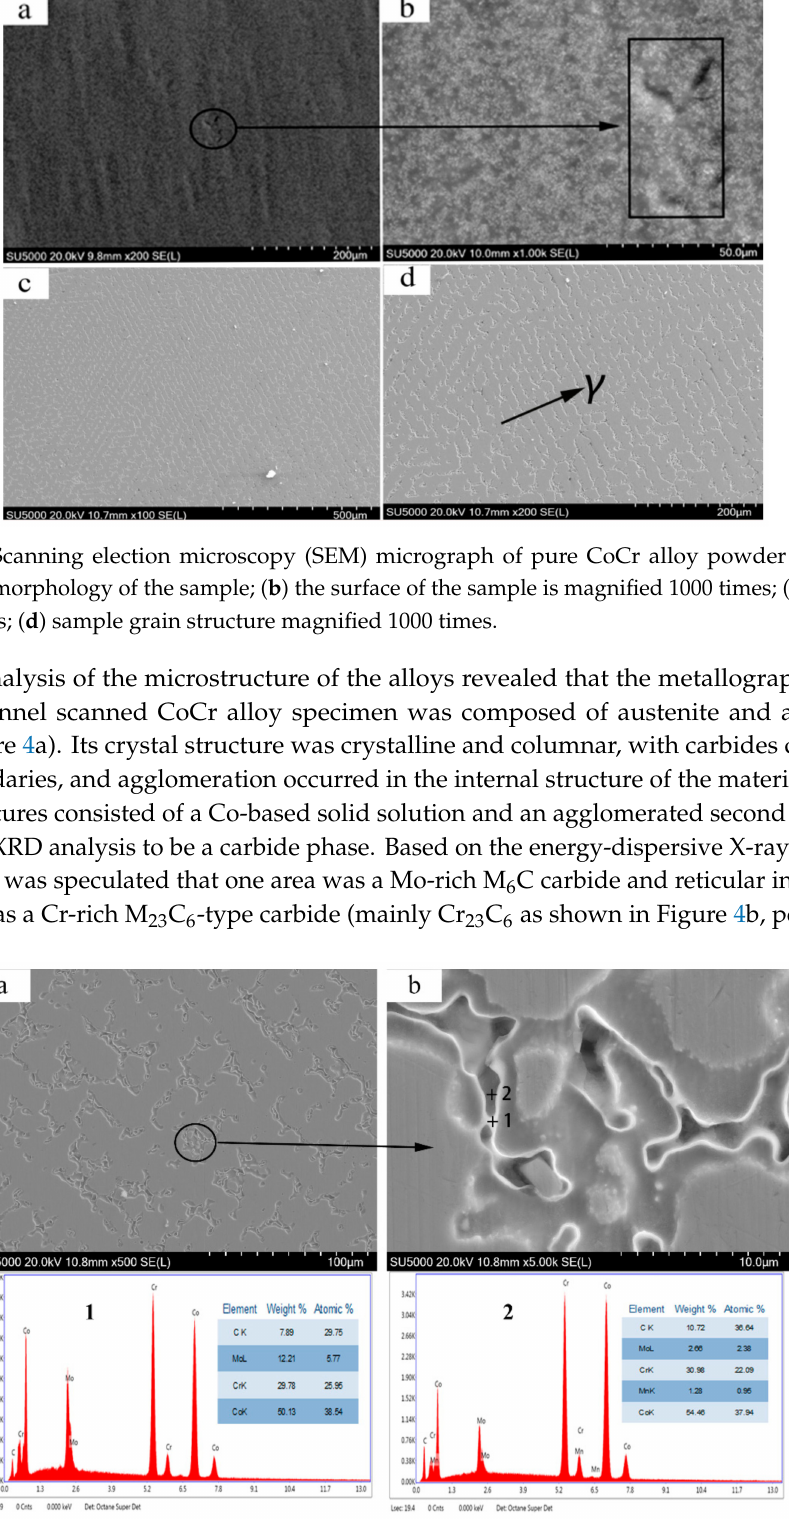
Figure 4. Microstructure of 0% added Al 2 O 3 samples and X-ray spectroscopy (EDS) analysis. ( a ) Microstructure of cobalt-chromium alloy; ( b ) partially magnified tissue